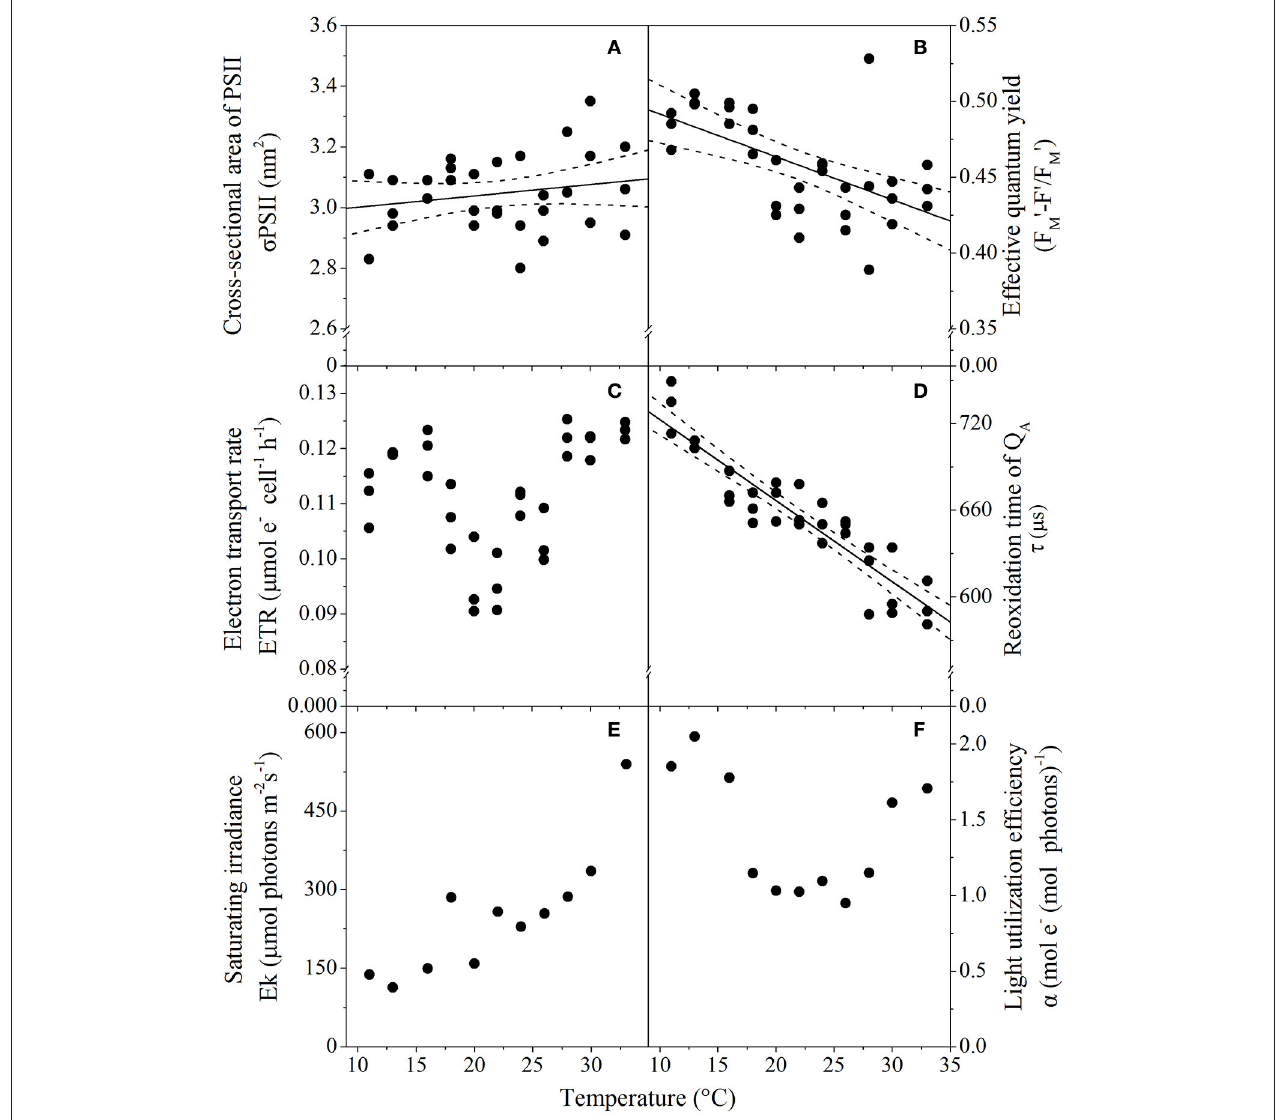
FIGURE 4 | Thermal performance curves of T. pseudonana photophysiological traits relating to light acquisition and harvesting depicting (A) Functional cross-sectional area of PSII ( n = 32, p = 0.03, R 2 = 0.59); (B) Effective quantum yield ( n = 33, p < 0.01, R 2 = 0.32); (C) Electron transport rate ( n = 33, p = 0.23, R 2 = 0.01); (D) Reoxidation time of Q A ( n = 33, p < 0.01, R 2 = 0.59); (E) Saturating irradiance ( n = 12); and (F) Light harvesting efficiency ( n = 12), as a function of temperature. Cells were harvested from cultures grown at 50 µ mol photons m − 2 s − 1 , with each symbol representing a distinct biological replicate. Solid line corresponds to maximum likelihood estimate with broken lines corresponding to the 95% confidence intervals of a linear regression, all estimated by parametric bootstrapping. (E,F) Data shown are parameters derived from rapid light curves with a single biological replicate, hence no MLE and confidence